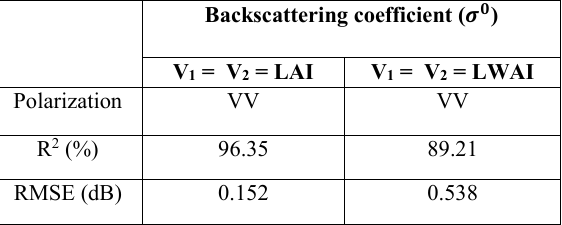
Table 4.Performance indices for estimation of σ 0 (dB) with different vegetation descriptor